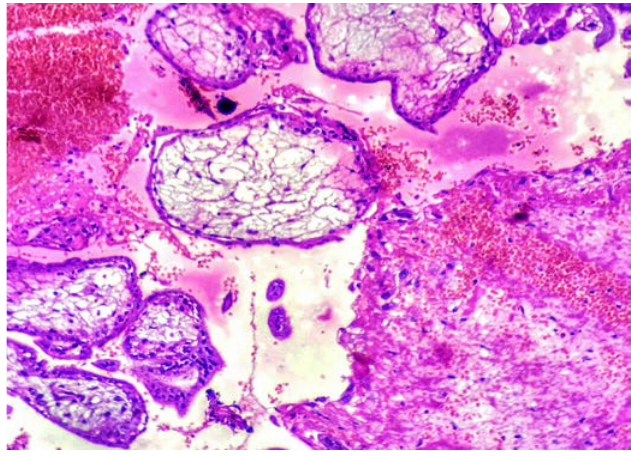
Fig 1 : Fibrosis in the fallopian tube due to previous ligation.